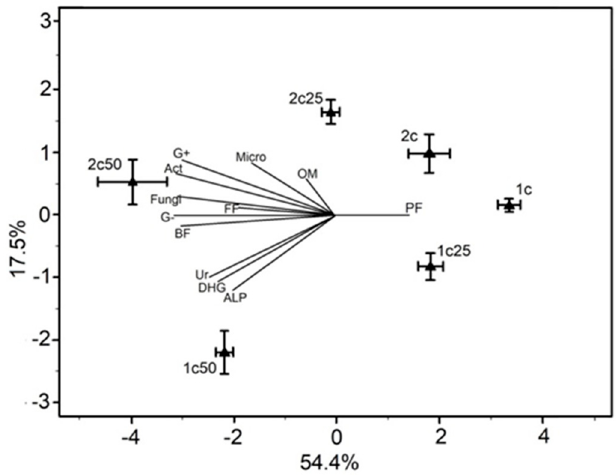
Figure 3. Mean values (± st. error) of variables for nematode trophic group abundances and results of PERMANOVA associated with “treatment” (T) and “duration of treatment” (D) on these parameters. Different letters (a, b) indicate significant differences of pairwise comparisons among treatments (Control, C 25 and C 50 ). The results of principal component analysis (PCA), depicting the ordination of samples and variables are presented in Figure 4. The first axis explained 54.4% of the data variability, while the second one explained 17.5% (71.9% in total). Samples of the C 50 for both durations were ordinated at the left part of the first axis showing a positive correlation mostly to Gram − , Gram + , fungi, and bacterial-feeding nematodes. The samples of control and C 25 of 15DAA were placed at the right side of the first axis showing a positive correlation to plant-feeding nematodes. Samples of 15DAA were separated along the second axis from all other samples and were ordinated in the lower part, showing a positive correlation to urease, dehydrogenase and alkaline phosphatase activities.